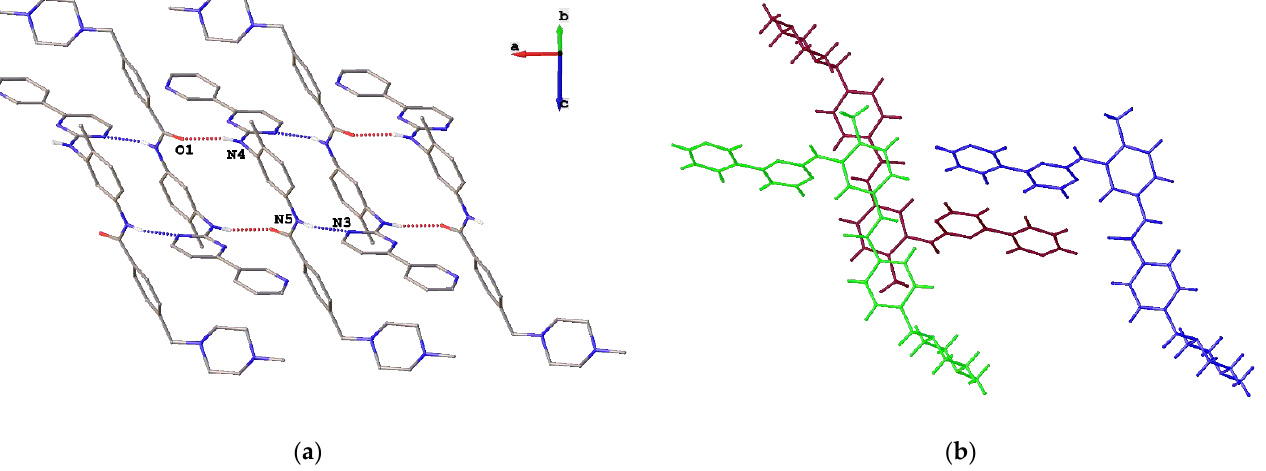
Figure 3. Fragment of crystal packing: ( a ) fragment of H-bonded chains parallel with the crystallo- graphic a-axis; ( b ) stacking interactions between two pyridylpyrimidine (red and blue) and two carbamoylbenzyl (red and green) fragments.